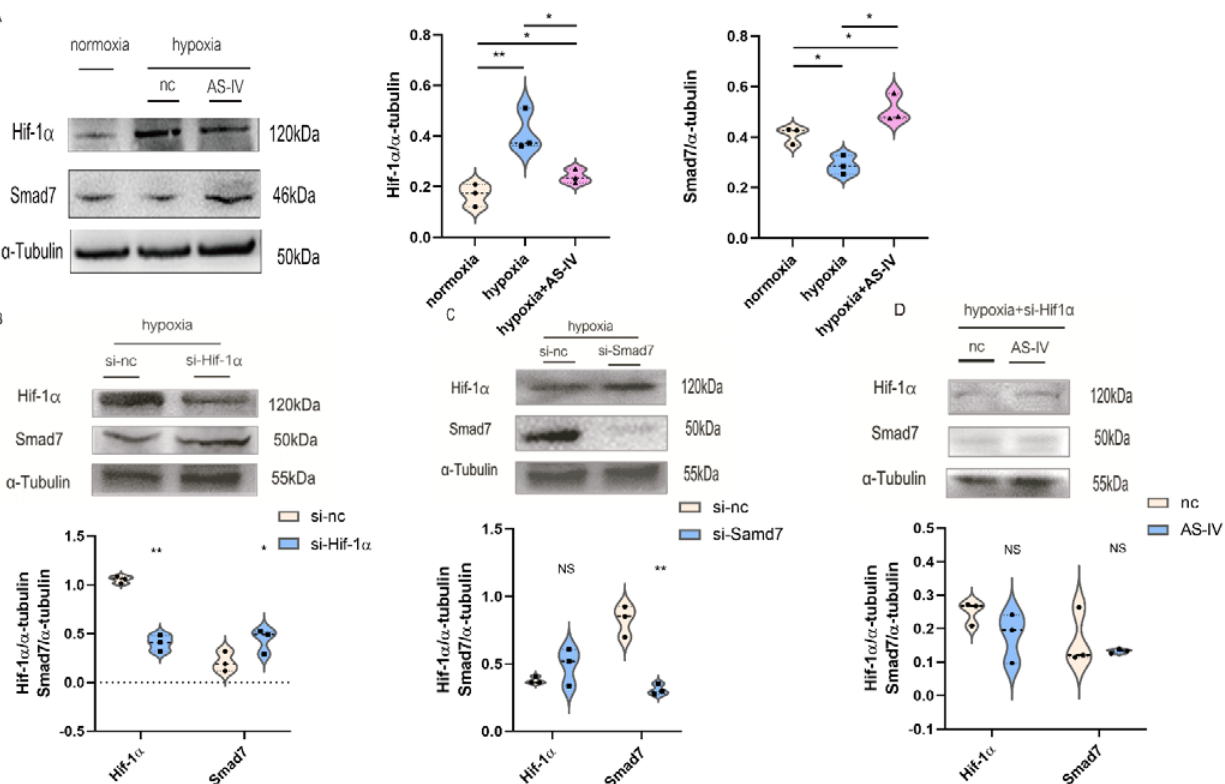
Figure 8. AS-IV regulates M2 macrophages through Hif-1 α /Smad7 signaling pathway. ( A ) Western blot results of Hif-1 α and Samd7 in M2 macrophages under normoxia, hypoxia, hypoxia with AS-IV. ( B ) Western blotting results of Smad7 after transfection of Hif-1 α siRNA or si-nc in M2 macrophages under hypoxic conditions. ( C ) Western blotting results of Hif-1 α after transfection of Smad7 siRNA or si-nc in M2 macrophages under hypoxic conditions. ( D ) Western blot results of Hif-1 α and Samd7 in M2 macrophages transfected of Hif-1 α siRNA under hypoxic conditions with or without AS-IV. n = 3 in each group. NS, no significance, * p < 0.05, * * p < 0.01.